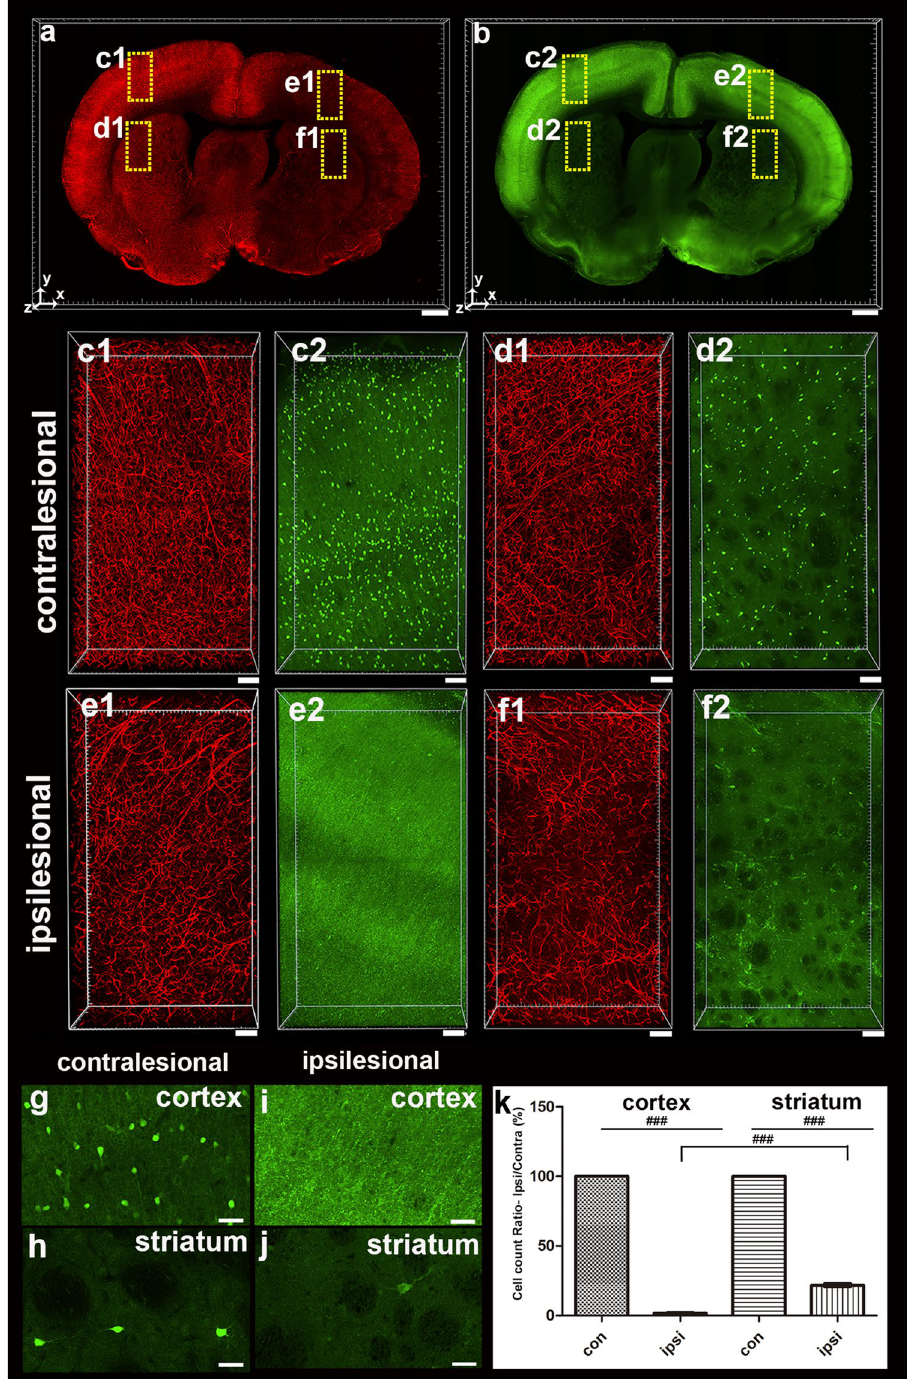
Figure 4. 3D visualization and quantification of PV-positive cell and vascular reduction 24 h after MCAO. ( a and b ) 3D reconstruction of the 0.5-mm-thick rat brain slice stained with lectin ( a ) and PV ( b ). ( c – f ) Higher- magnification views of the boxed regions in ( a , b ) are shown. There was a vascular density loss and PV-positive cell loss in the ipsilesional cortex and striatum compared with the contralateral side. ( g – j ) Morphological change in PV-positive cells in the injured cortex and striatum compared with the contralateral side. ( k ) Graph of the ratio of PV-positive cells using automated cell count in the ipsilateral areas to the corresponding contralateral areas of the cortex and striatum 24 h after ischemia using a spot detection strategy generated with Imaris v.9.5.0 software (measures 3–4 cortical and striatal fields per animal, n = 3 animals). Data are presented as the mean percentage relative to corresponding contralateral areas ± SEM. Paired t-test, FDR multiple comparison test, ### p < 0.001, Scale bar = 1 mm in ( a , b ), 100 μm in ( c – f ), 50 μm in ( g – j